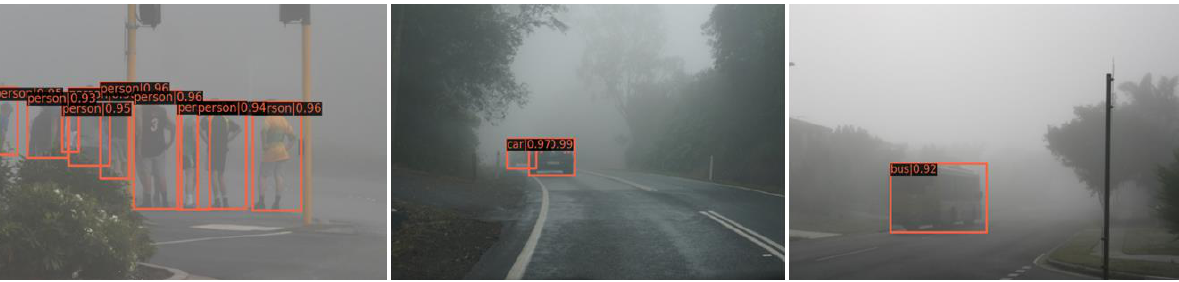
Figure 13. Visualization of detection results on the foggy driving dataset. Table 7. Experimental results on foggy driving dataset (the top three performances are highlighted in red, blue, and green, bold denotes our algorithm.).